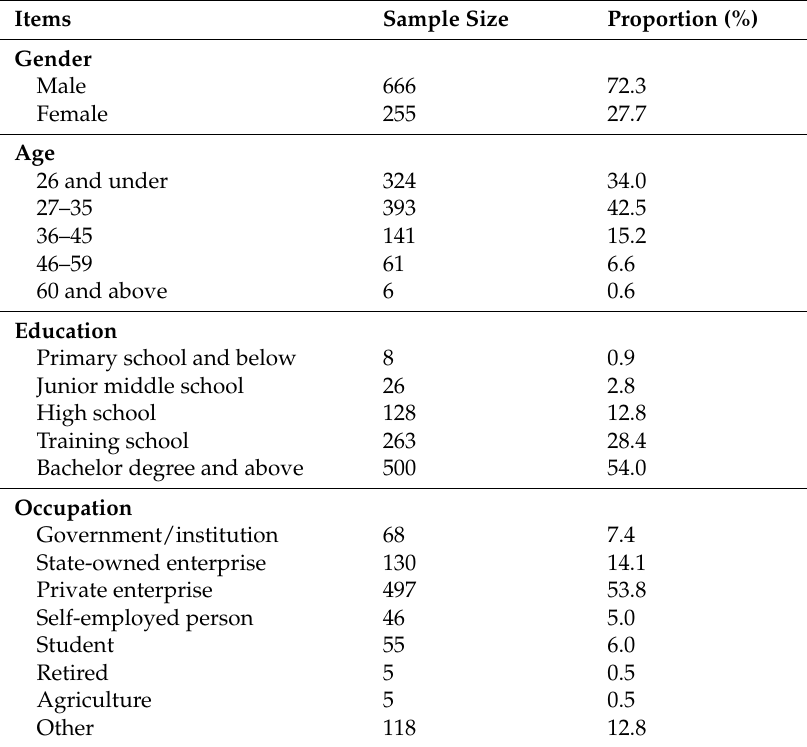
Table 3. The demographic characteristics of the